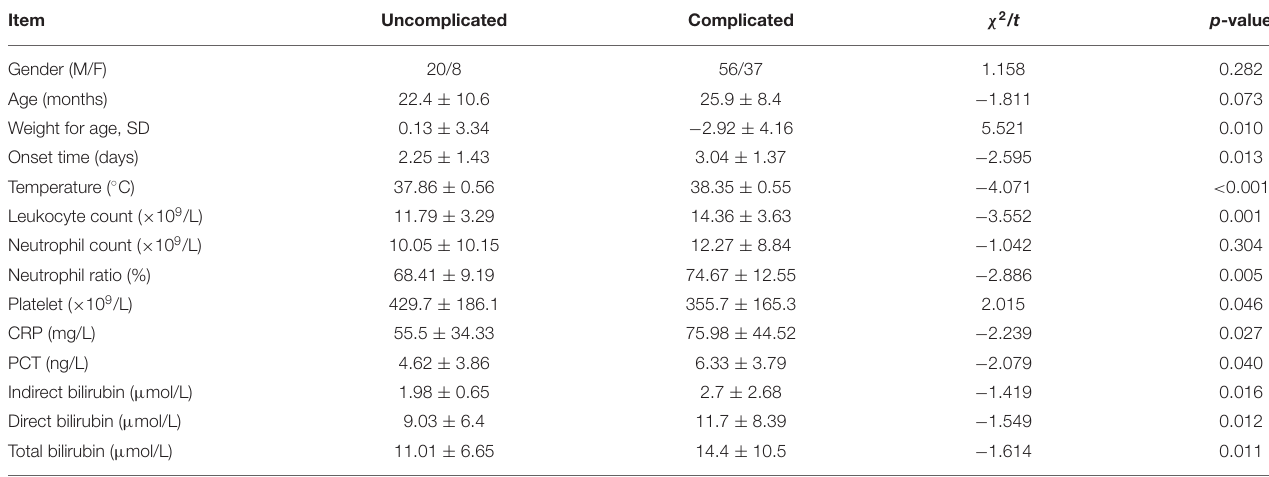
TABLE 1 | Comparison of admission information between the two